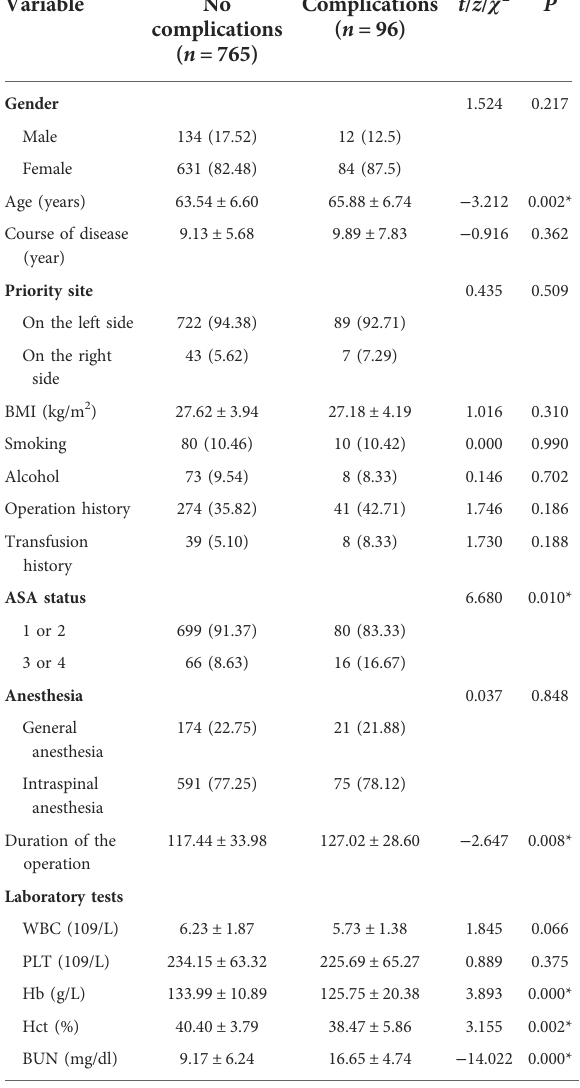
TABLE 1 Univariate analysis of clinical data of the two